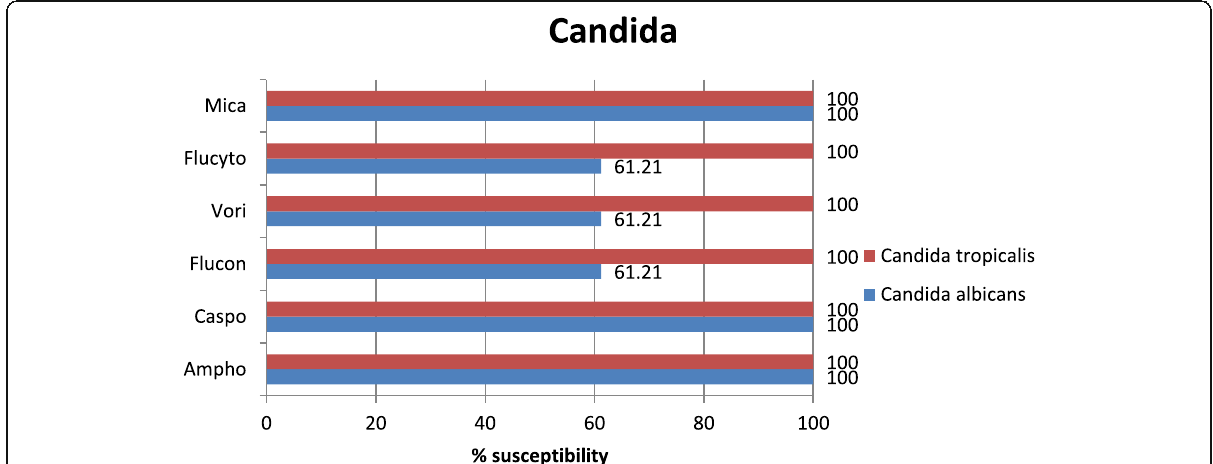
Fig. 8 Antifungal susceptibility of Candida species. Ampho amphotericin B, Caspo caspofungin, Flucon fluconazole, Vori voriconazole, Flucyto flucytosine, Mica